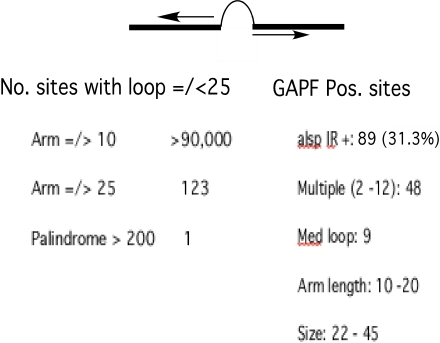
A significant portion of GAPF-detected palindromes in DT40 cells occurs at sites of short IRs in chicken DNA.A generalized short IR is depicted with the complementary “arms” as a thick black line separated by a non-complementary “loop” sequence. The column on the left lists numbers of IRs with loops of 25 nucleotide base pairs or less. These numbers drop dramatically as arm length increases from a minimum of10 base pairs to a minimum of 25 base pairs. Only one palindrome was detected with an arm length greater than 200 base pairs. On the right are listed the relevant features of 89 IRs with loops of up to 25 base pairs found within 1 kb of 284 apparent palindromes that were detected in 50% or more of GAPF studies of DT40 cells. Most of these GAPF positive sites had multiple nearby IRs with loop sizes, arm lengths and overall sizes as shown.